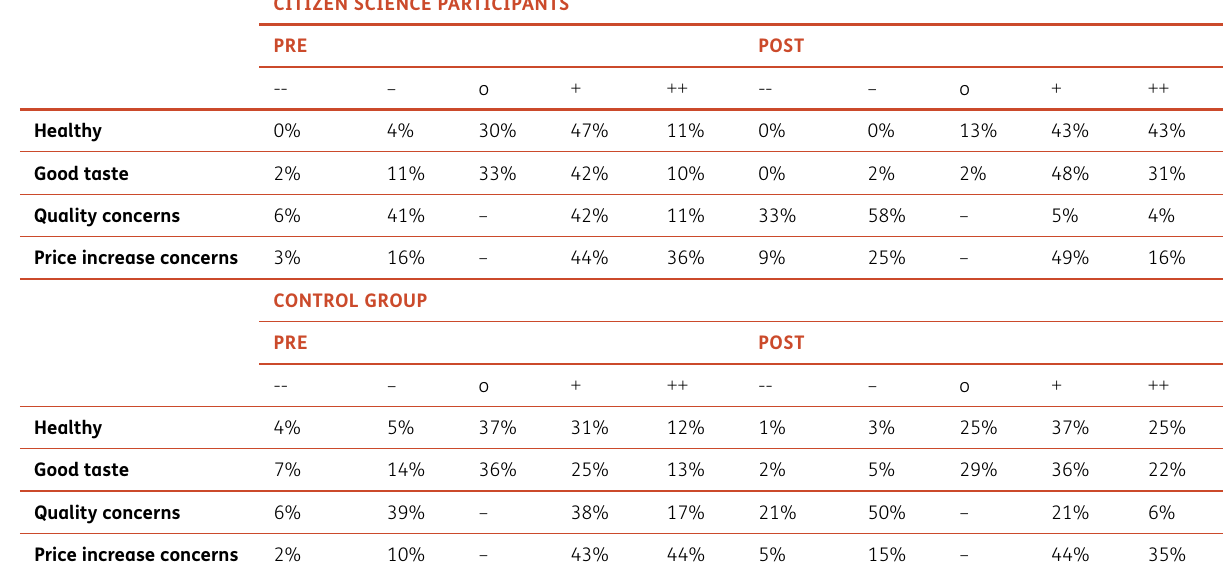
Table 3 Perceptions about drinking water, expressed in the range of disagreement/agreement (five possible responses) for health and good taste) and little or many concerns (four possible responses) for the water quality and price